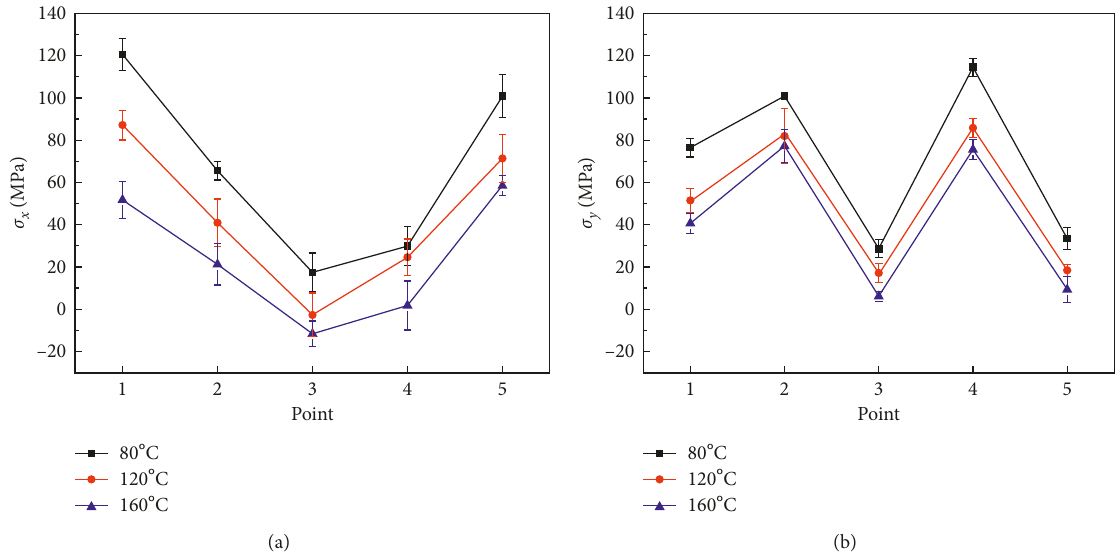
Figure 8: Chessboard scanning. (a) Residual stress in X direction. (b) Residual stress in Y direction.